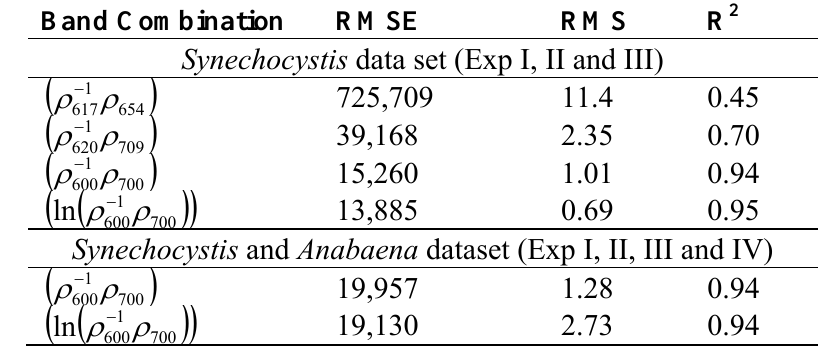
Table 3. Model validation results: root-mean-square-error (RMSE) in cells mL –1 , relative root-mean-square-error (RMS), and coefficient of determination (R 2 ) are reported for all